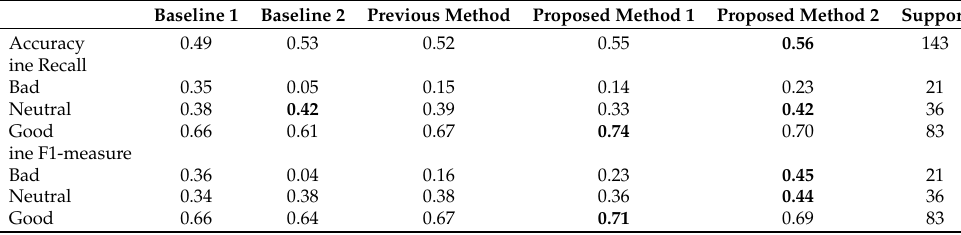
Table 8. Estimation accuracy of five methods for MQ.